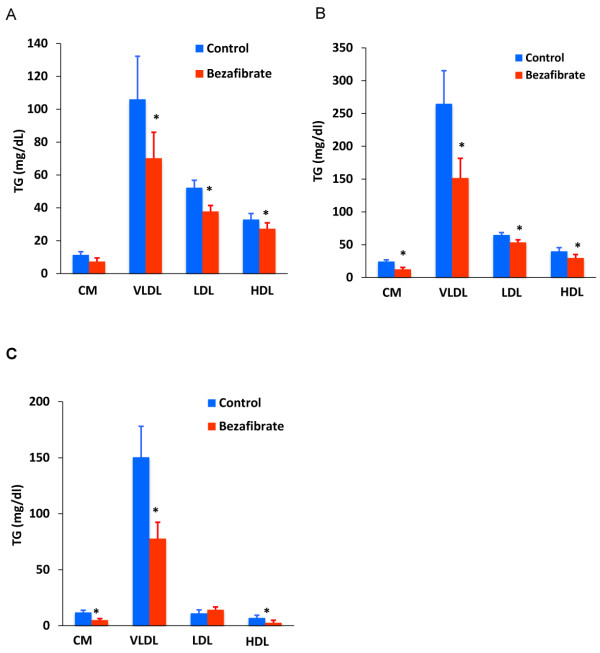
TG content of lipoprotein fractions in the size range of CM, VLDL, LDL, and HDL in the control and bezafibrate groups in the fasting state (A) and 4 h after cookie ingestion (B). The change in the TG content of lipoprotein fractions in the size range of CM, VLDL, LDL, and HDL from the fasting state to 4 h after cookie ingestion (C). Data are expressed as mean ± SE. *p < 0.05 vs. control group.